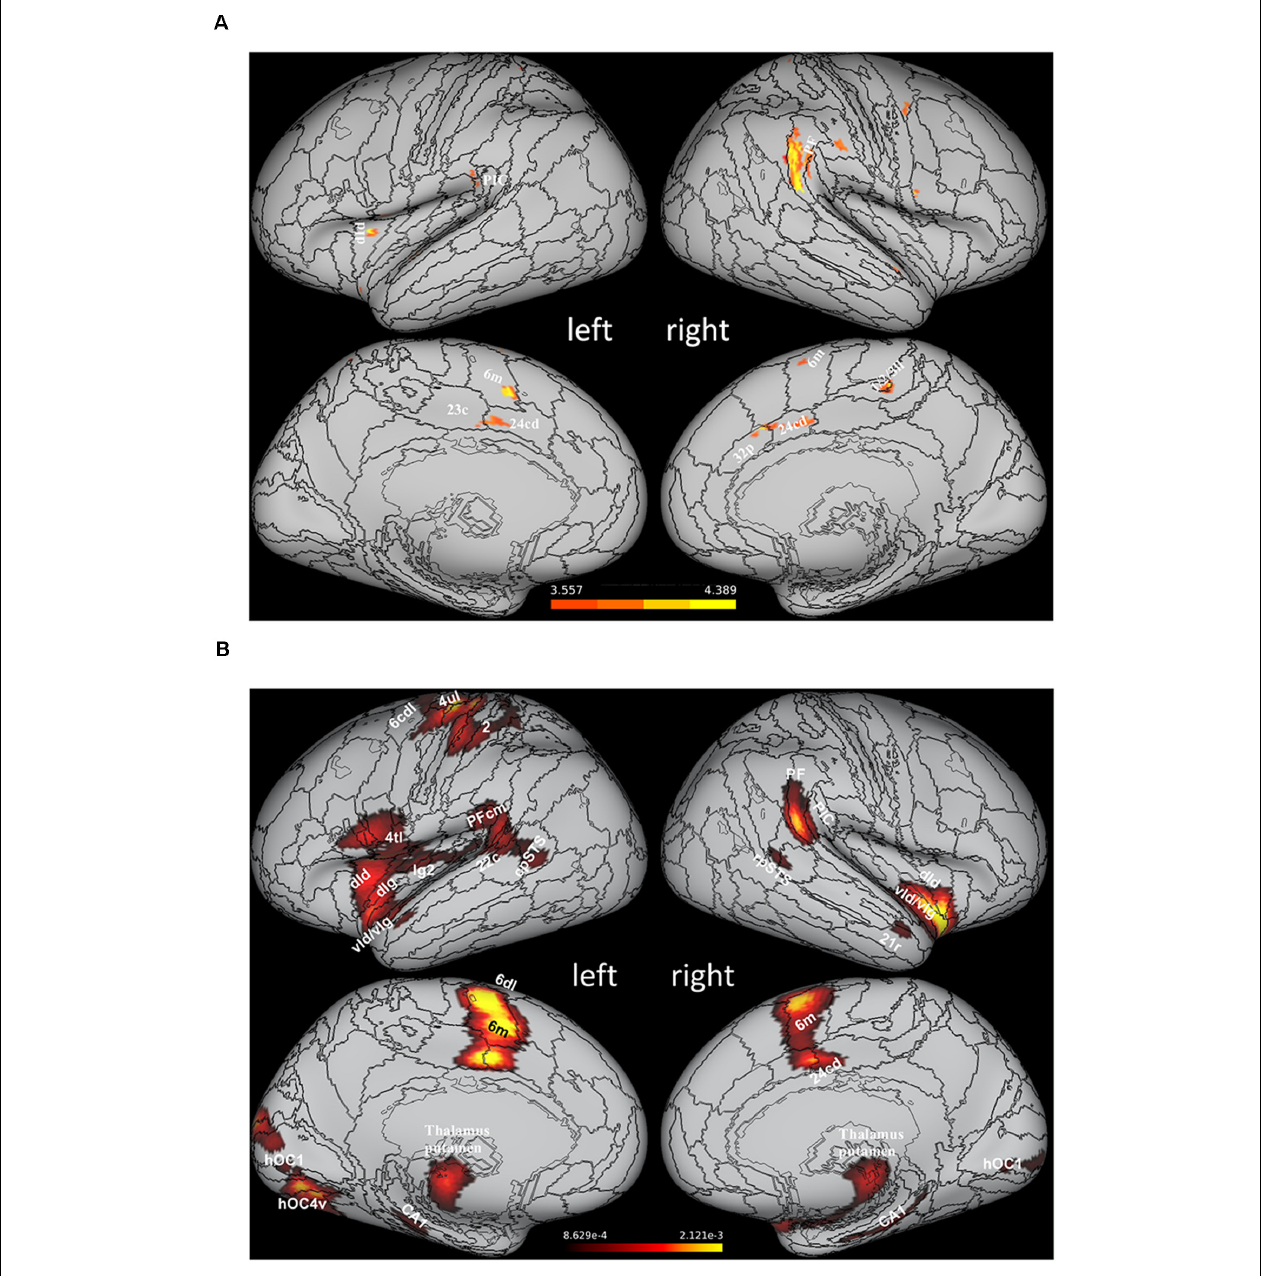
FIGURE 2 | Areas of the vestibular network activated preferentially by stimuli congruent with the effects of gravity. (A) Statistical activation map resulting from the intersection of the brain activation map evoked by caloric stimulation and that derived by the statistical contrast between the activity evoked by visual motion congruent (1 g ) and non-congruent ( − 1 g ) with gravity (data from Indovina et al., 2005 replotted on the Conte69 inflated brain template). (B) Statistical activation map obtained with an ALE meta-analysis of 88 activation foci drawn from six studies reporting preferential fMRI activations in response to stimuli congruent with effects of gravity (Indovina et al., 2005, 2013b, 2016; Miller et al., 2008; Maffei et al., 2010; Rousseau et al., 2016). The activation map, overlapped onto the Conte69 inflated brain template (Glasser et al., 2016), was thresholded at voxel level ( p < 0.05) and corrected at cluster level at p < 0.05 (Eickhoff et al., 2012). Given the limited number of foci and the compliant statistical thresholds used for the meta-analysis, this activation map should be considered for illustrative purposes rather than statistical ones in a strict sense. Labels correspond to: rostroventral area 40 (PIC), area supramarginalis (PF), area supramarginalis columnata magnocellularis (posterior; PFcm), ventral dysgranular and granular insula (vId/vIg), dorsal granular insula (dIg), dorsal dysgranular insula (dId), dorsal granular insula (dIg), granular insula 2 (Ig2), caudal dorsolateral area 6 (6 cdl), medial area 6 (6 m), area 4 (upper limb region, 4ul), area 4 (tongue and larynx region, 4tl), area 2 (2), caudal area 22 (22 c), caudal dorsal area 24 (24 cd), caudal area 23 (23 c), caudal dorsal area 24 (24 cd), posterior area 32 (32p), area1/2/3 (lower limb region, 1/2/3ll), rostral posterior superior temporal sulcus (rpSTS), caudal posterior superior temporal sulcus (cpSTS), cornu ammonis 1 (CA1), rostral area 21 (21r), human V1 (hOC1), human ventral V4 (hOC4v). PIC, posterior insular